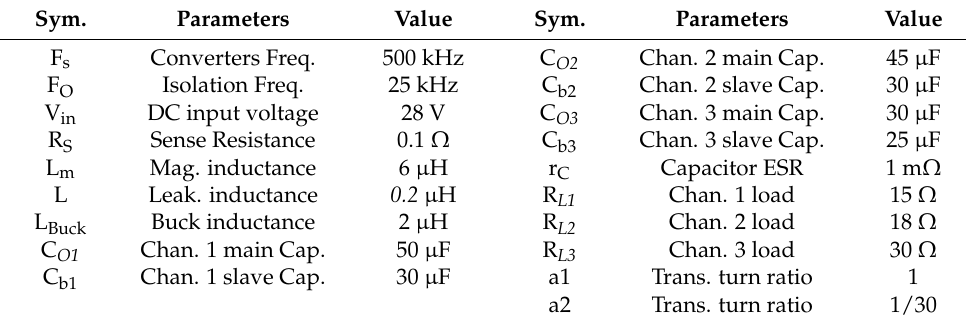
Table 1. Circuit